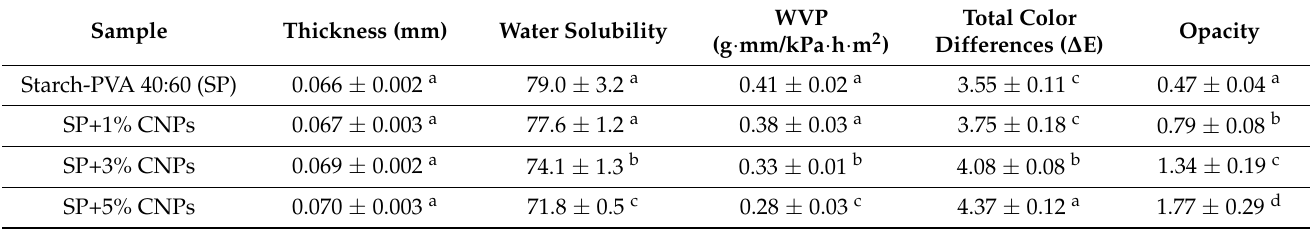
Table 2. Physical properties of starch-PVA nanocomposite films loaded with different amounts of CNPs.